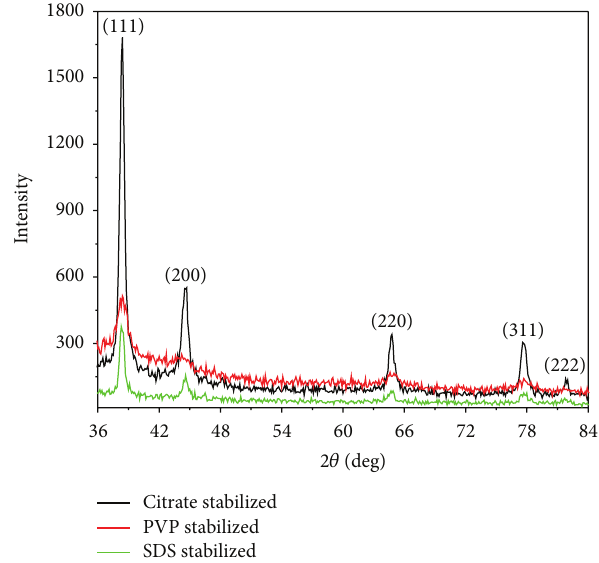
Figure 5: The XRD pattern of capped silver nanoparticles, indicat- ing the face centered cubic (fcc) crystal structure.